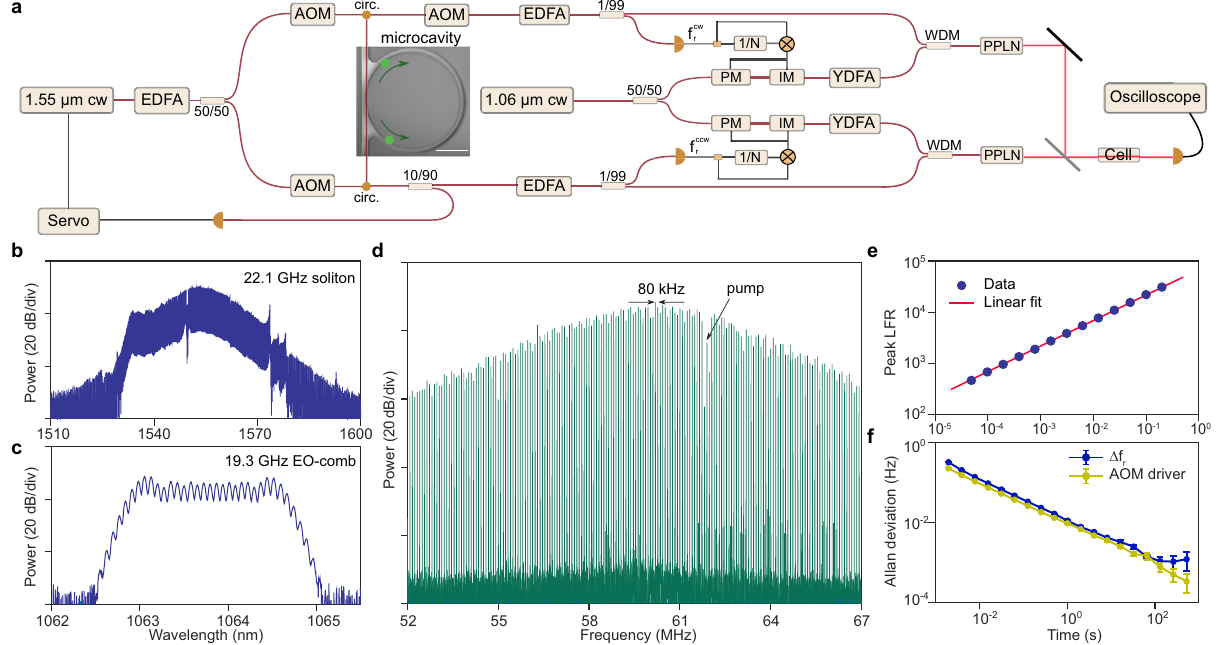
Fig. 1 Experimental setup of the GHz-mid-IR DCS system. a Counter-propagating (CP) solitons at 1.55 μ m are generated in a silica microcavity to provide two of four comb signals. These solitons are photo-detected and the resulting signals are processed to create the two other comb signals by electro-optic modulation at 1.06 μ m. These near-IR combs are combined in pairs to pump PPLN crystals for generation of GHz line spacing mid-IR combs by interleaved difference frequency generation. These mid-IR comb sources pass through a gas cell and are detected for dual-comb spectroscopy. Fiber Bragg grating fi lters used to fi lter pump waves in the soliton microcomb spectra are omitted in the fi gure. f cw r ( f ccw r ) corresponds to the cw (ccw) soliton repetition rates. AOM: acousto-optical modulator, circ: circulator, PM: phase modulator, IM: intensity modulator, EDFA: erbium-doped fi bre ampli fi er, YDFA: ytterbium-doped fi bre ampli fi er, WDM: wavelength division multiplexer, PPLN: periodically poled Lithium Niobate. Scale bar: 1 mm. b Optical spectrum